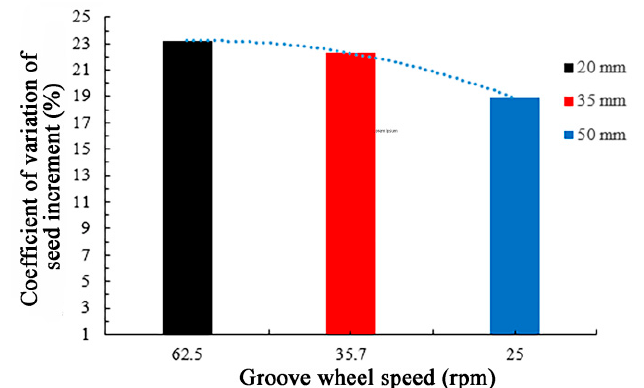
Figure 14. Effect of rotating speed on the coefficient of variation of seed quantity due to the change in wheel length.